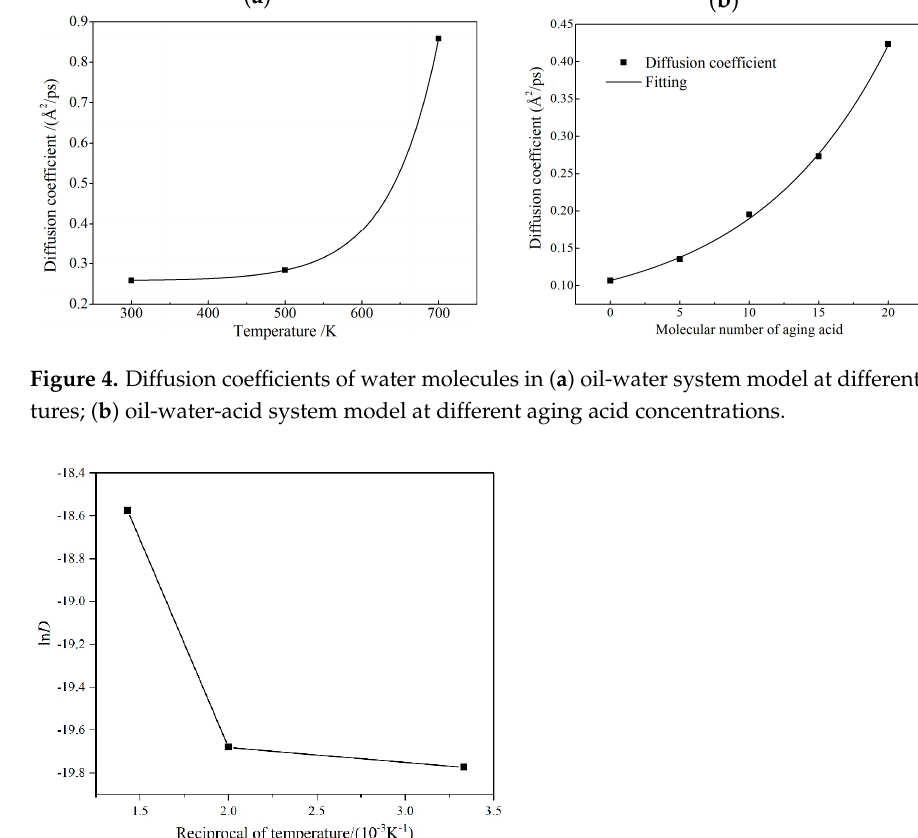
Figure 5. The relationship between ln D and the reciprocal of temperature.